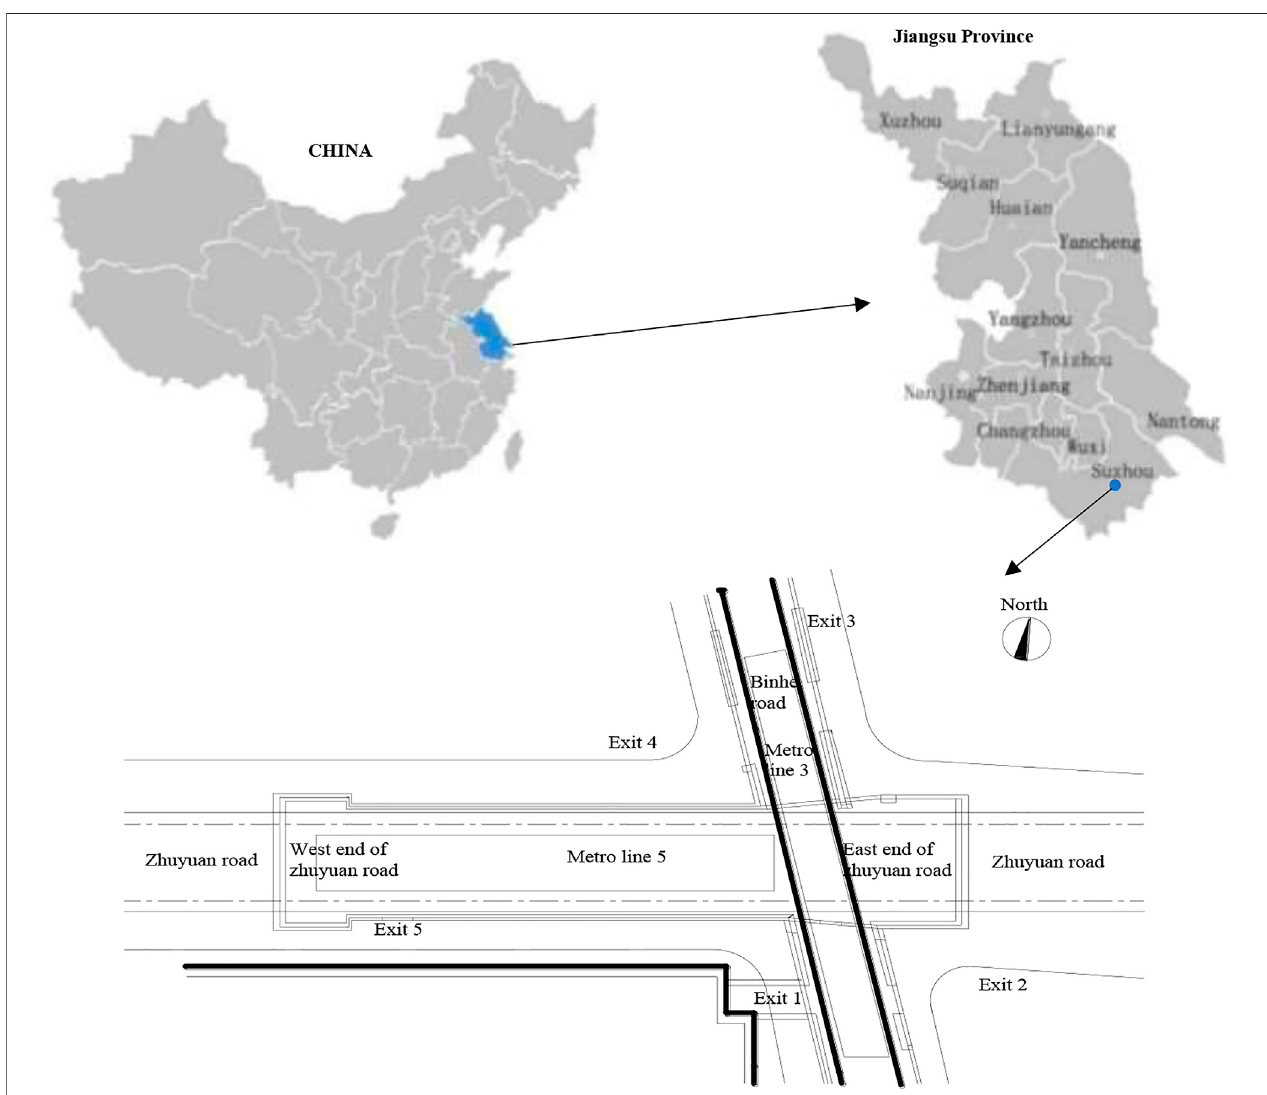
FIGURE 1 | Surrounding environment of Zhuyuan Road